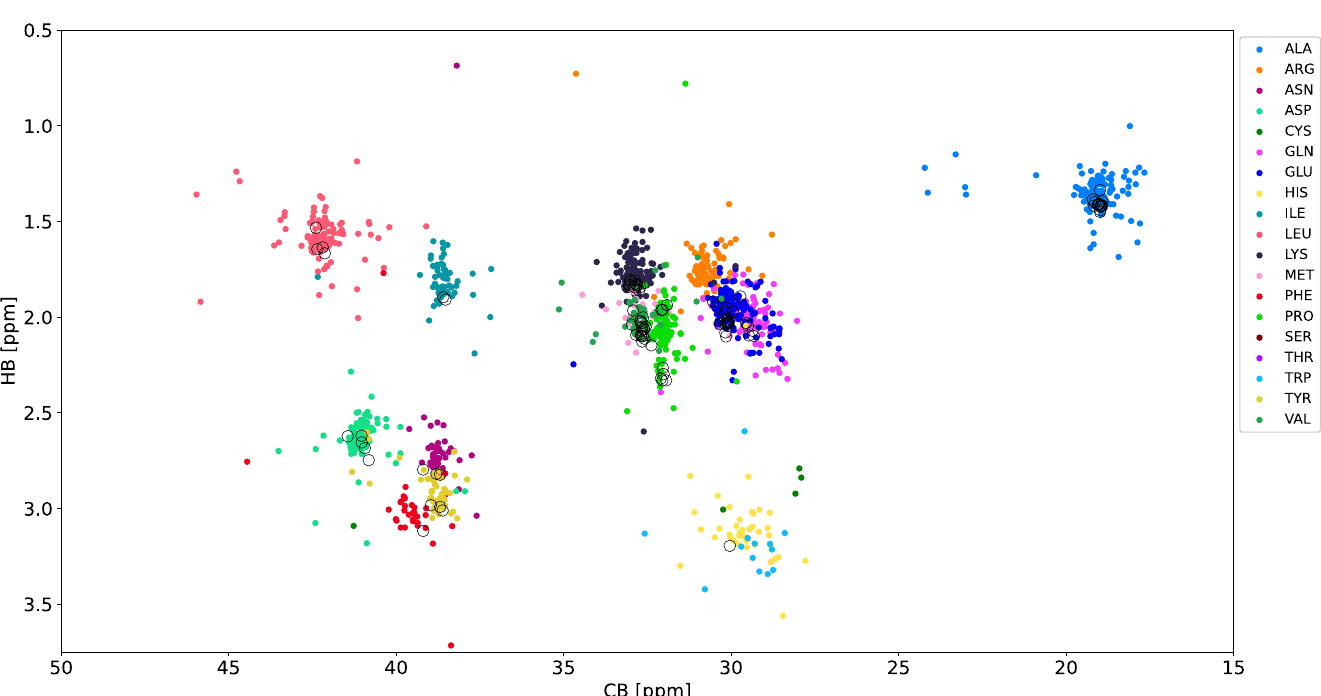
Fig 6. C β /H β plane showing the chemical shifts of 17 unfolded proteins from the BMRB (shown in different colors) and 2D projections of higher-dimensional spectra of α -synuclein (shown in